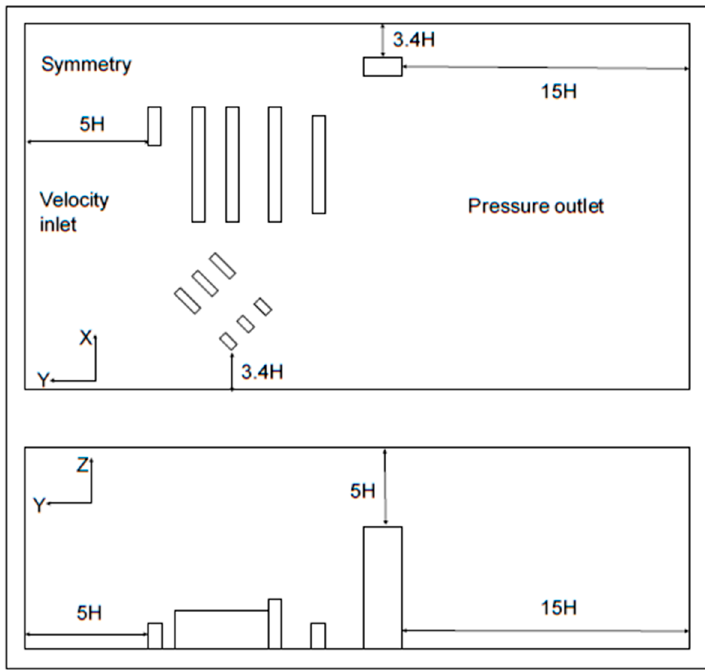
Figure 4. The arrangement and computational domain of twelve buildings.